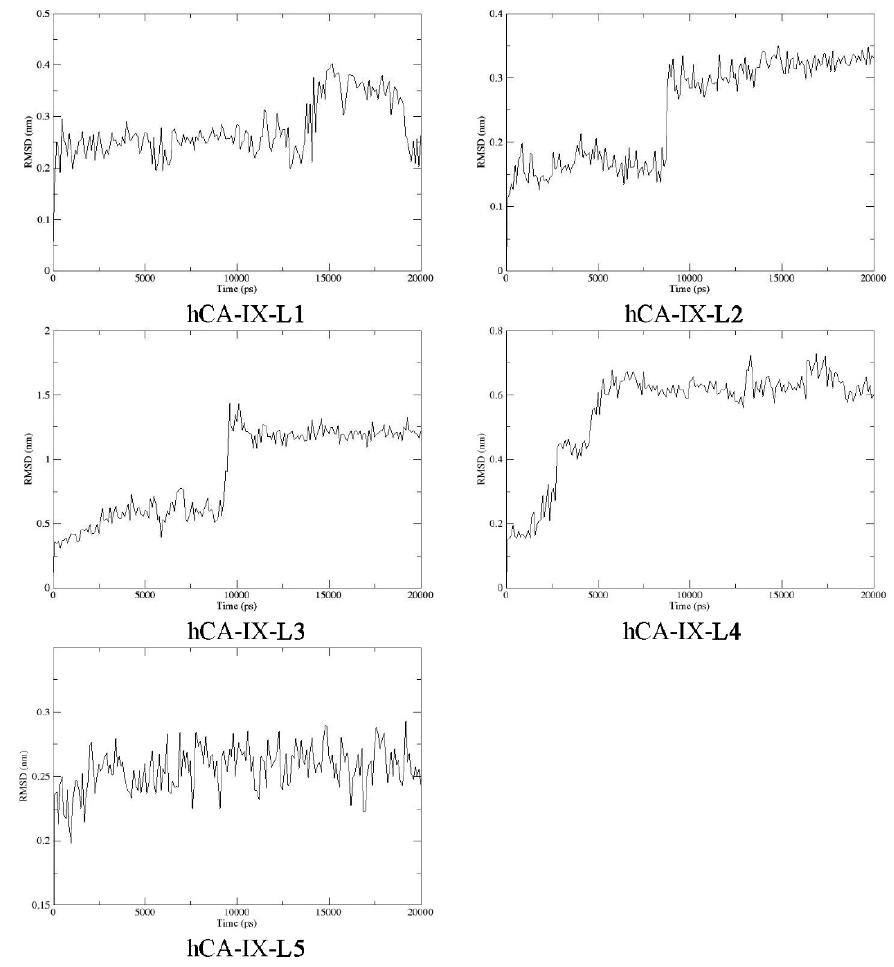
Figure 5. The plot of root mean square deviation (RMSD) of the C–C α –N backbone vs. simulation time for solvated hCA-IX in complex with all coumarin-neurotransmitter derivatives during 20 ns molecular dynamics simulations.